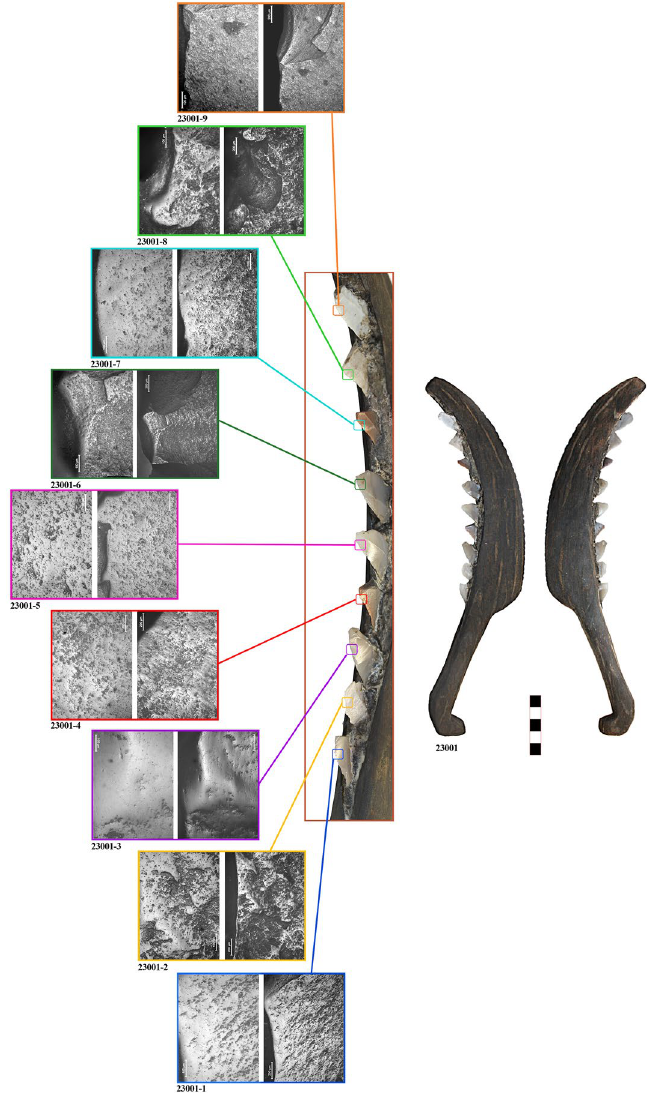
Figure 4. Sickle No. 23001 with macro and microscopic view of the lithic inserts (23001-1 to 23001-9). Micrographs have been taken at both 100 × and 200 × for each